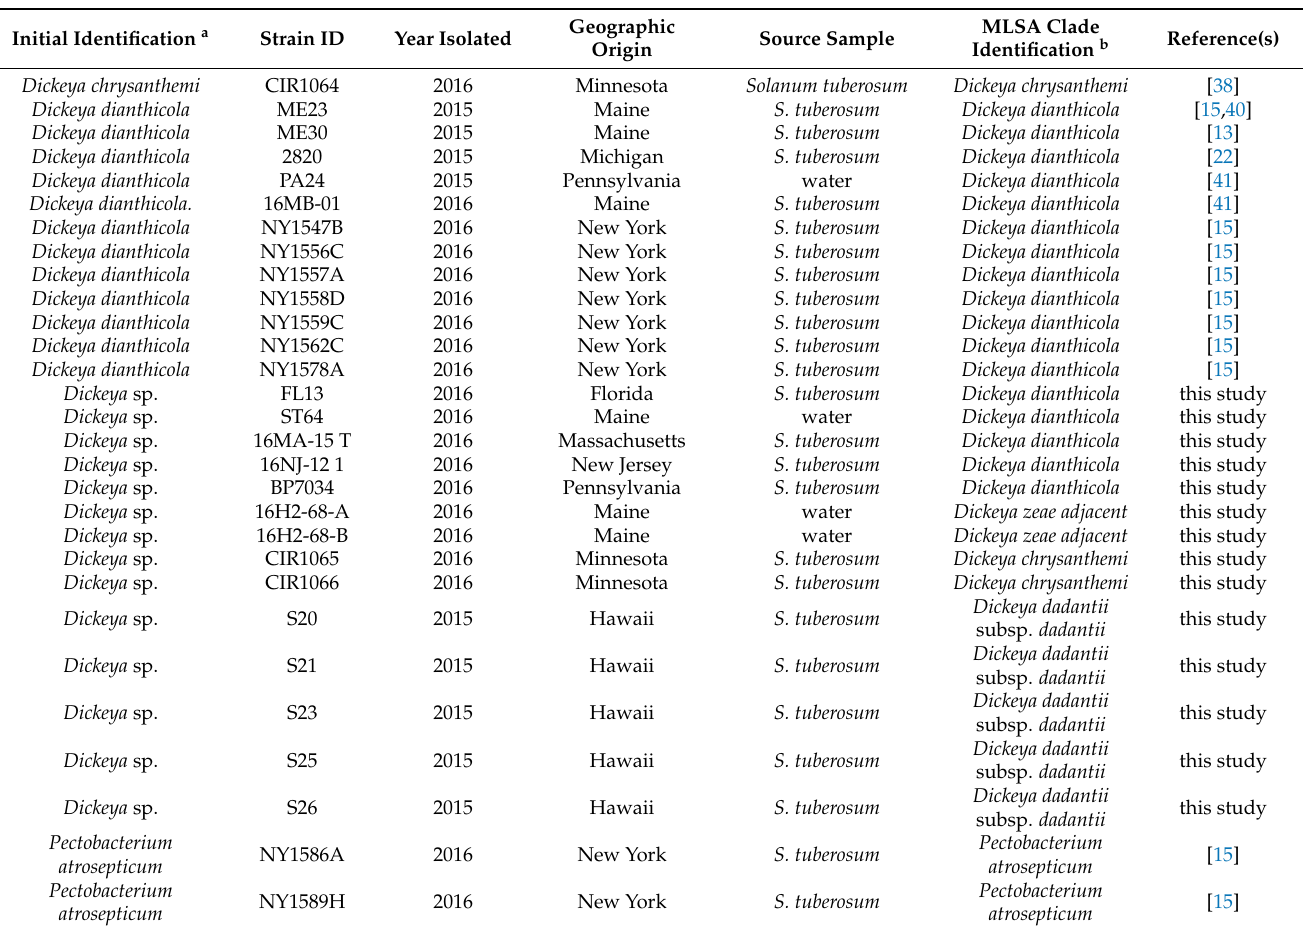
Table 1. Description and MLSA clade of Dickeya and Pectobacterium strains collected in 2015 and 2016 from production and testing areas associated with potato production in Northeastern and North Central U.S. Initial Identification